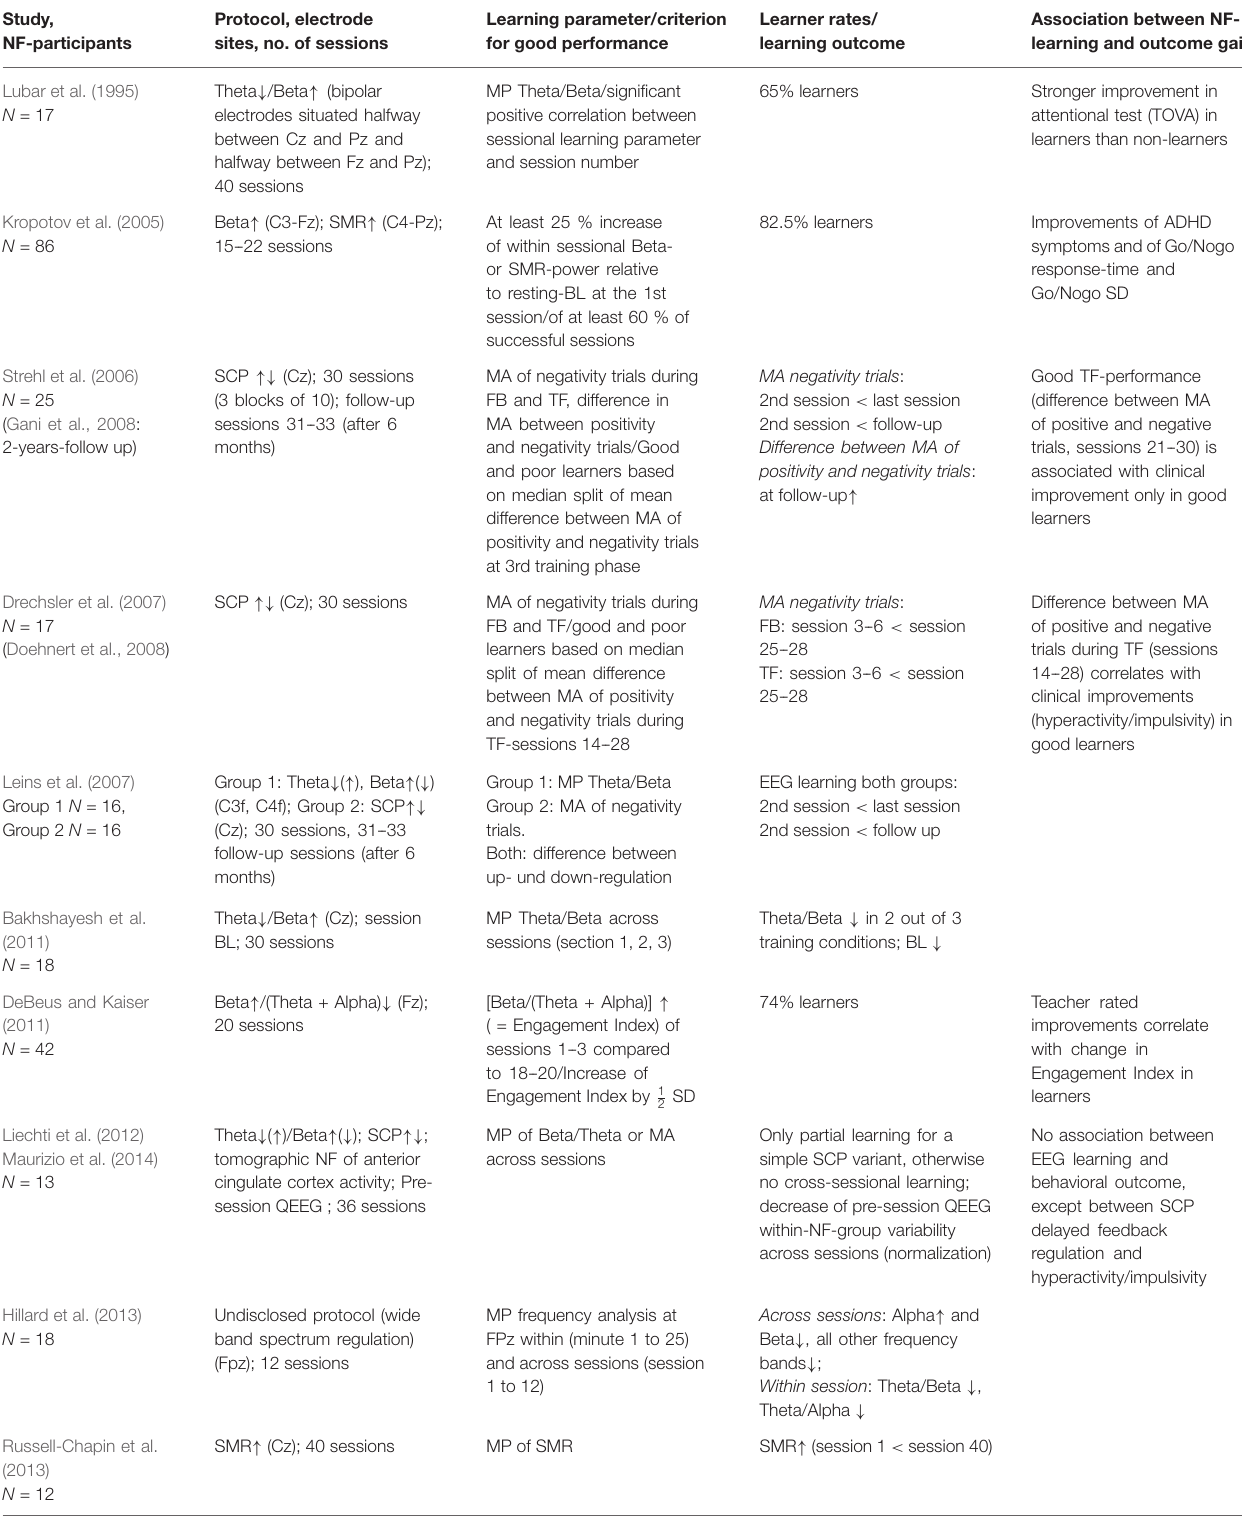
TABLE 1 | ADHD Neurofeedback studies analyzing learning of EEG regulation .